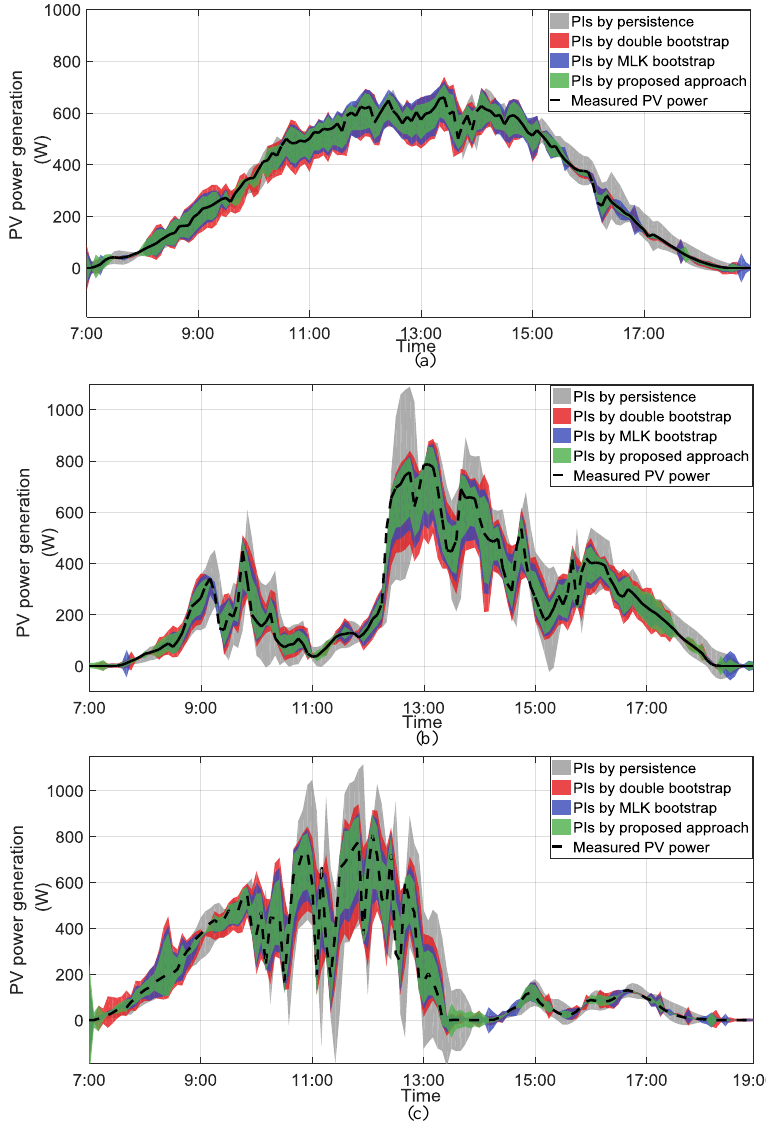
Figure 5. The 5-min ahead photovoltaic (PV) power forecasting results of typical weather conditions: ( a ) sunny conditions; ( b ) cloudy conditions; and ( c ) thunderstorm (PIs constructed by proposed model, double bootstrap, MLK bootstrap and PeEn, respectively) with 90% confidence level.